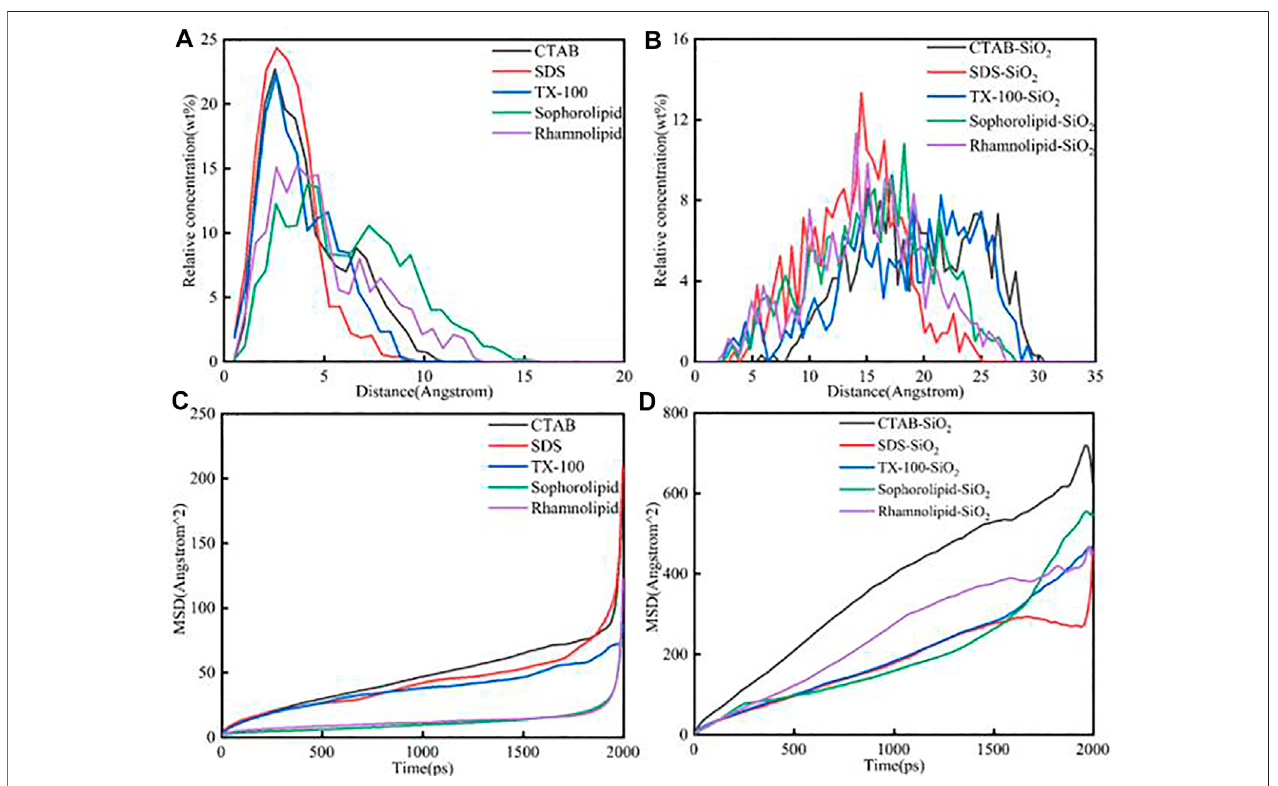
FIGURE 8 | The relative concentration of different (A) surfactants; (B) surfactants-SiO 2 nano fl uids system. The mean square displacement of different (C) surfactants; (D)